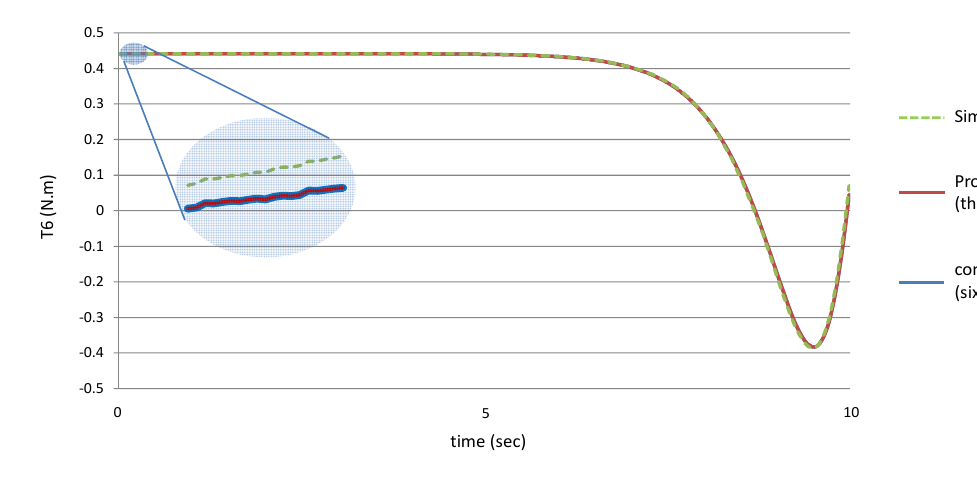
Figure 26. The torque of the third